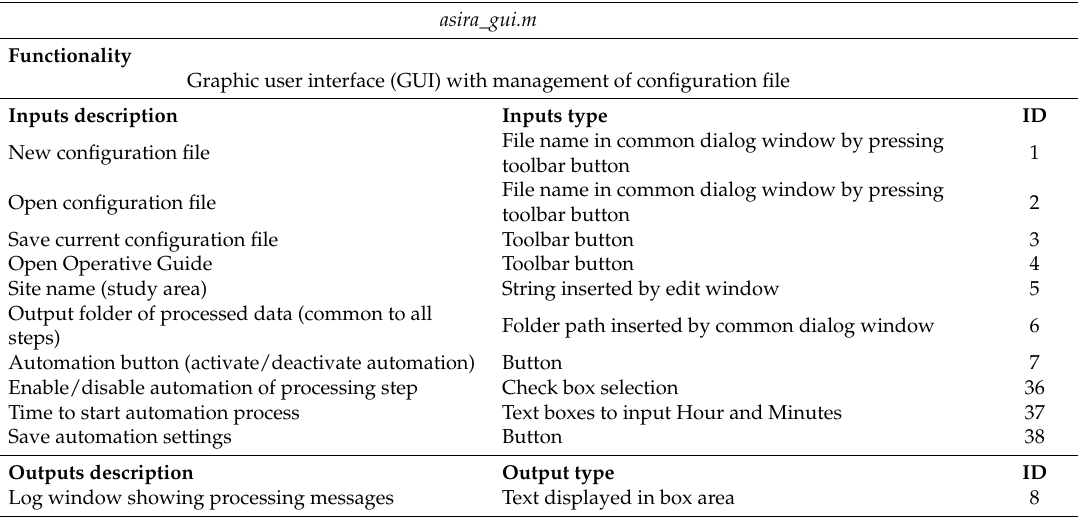
Table A1. Technical specifications of functionality and input/output data type of graphic interface.